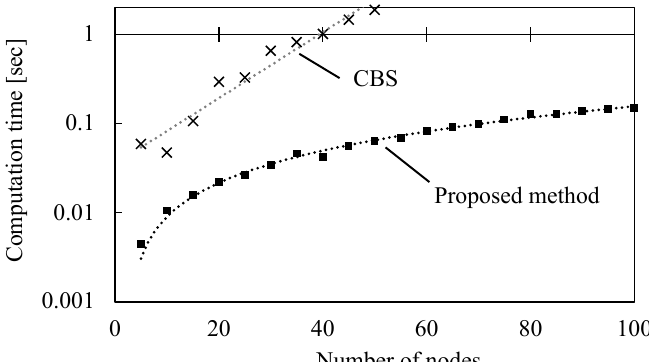
Figure 17. Computation time with respect to the number of nodes N .